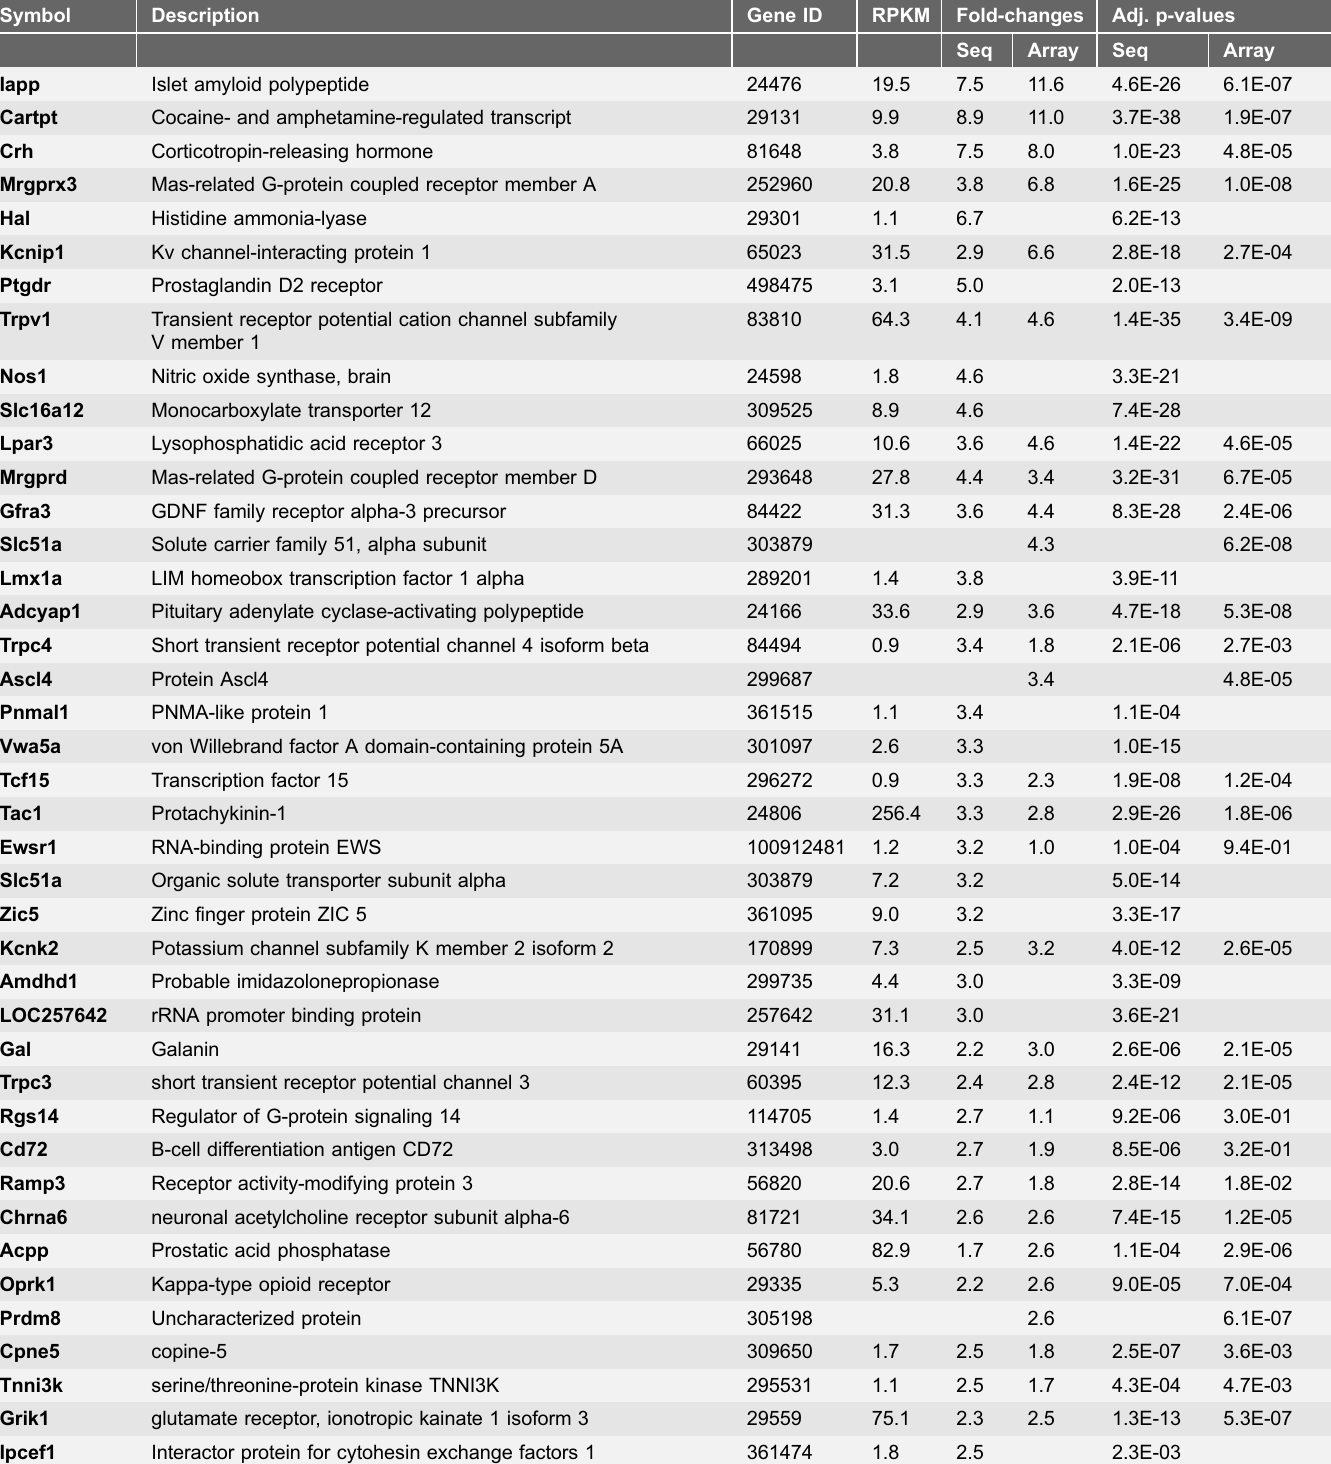
Table 1. Top 50 transcripts found with higher expression levels in TRPV1( + ) neurons by microarrays and/or RNA-Seq (adj. p , 0.05, fold-change . 1.5, RPKM . 0.5).